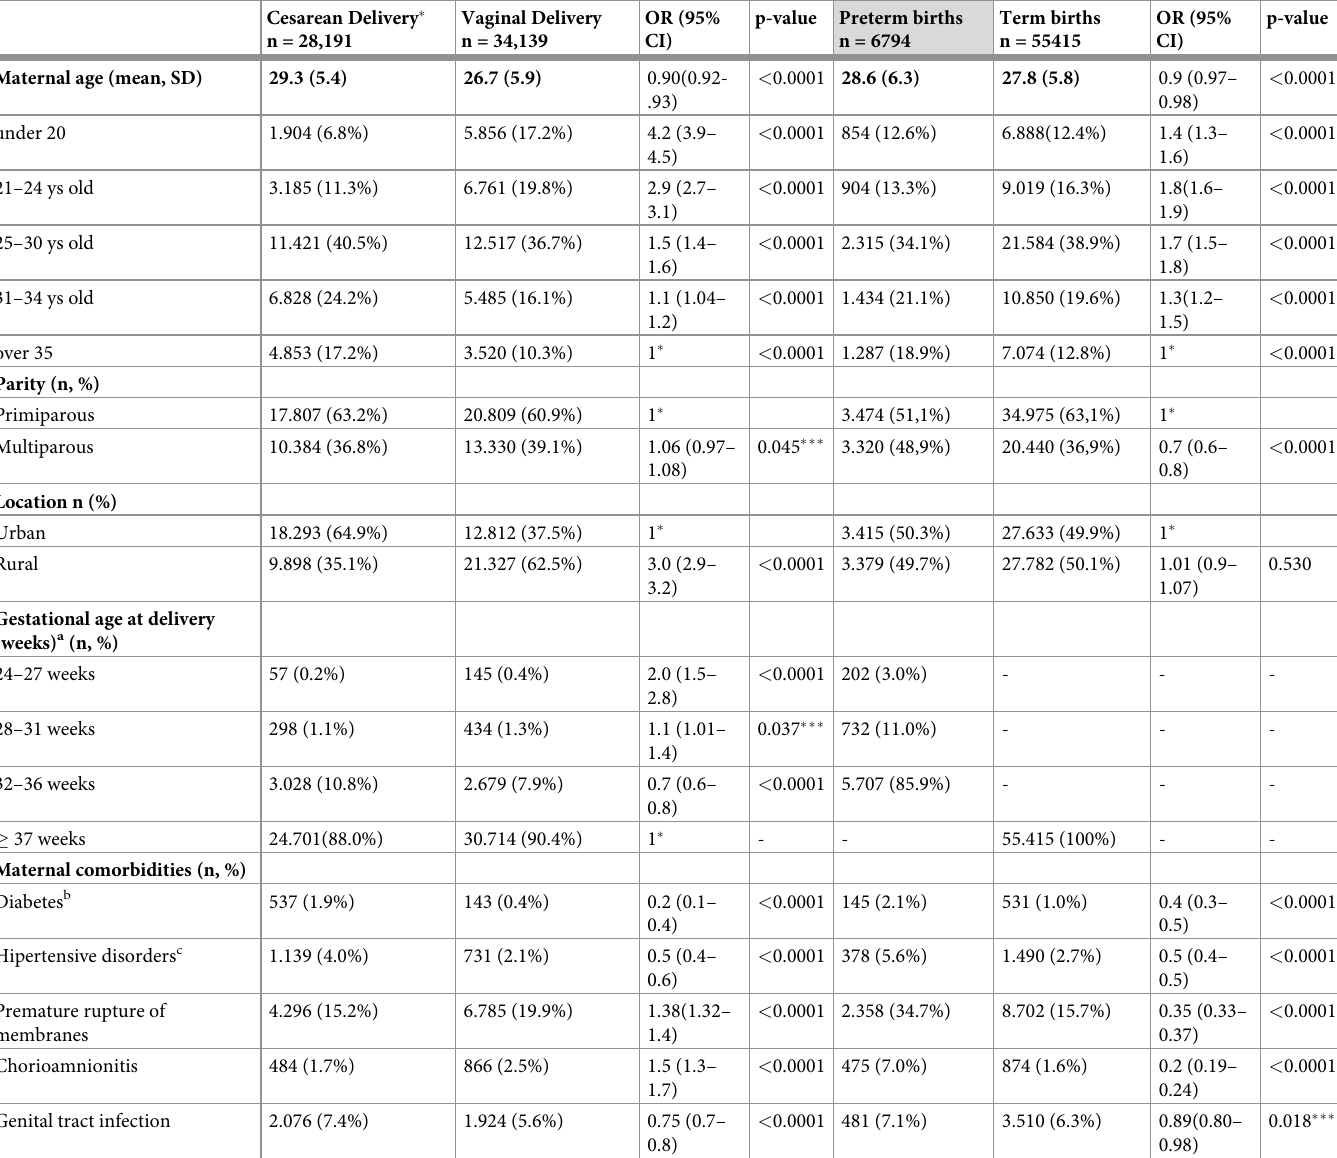
Table 1. Demographic and clinical characteristics of the study population, stratified by delivery mode and gestational age at